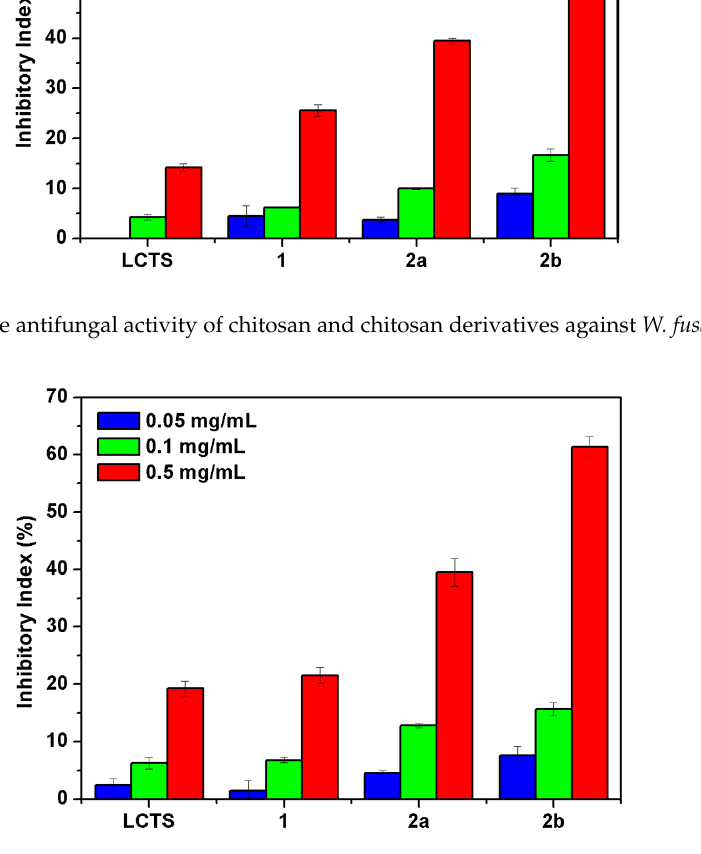
Figure 8. The antifungal activity of chitosan and chitosan derivatives against C. lagenarium .